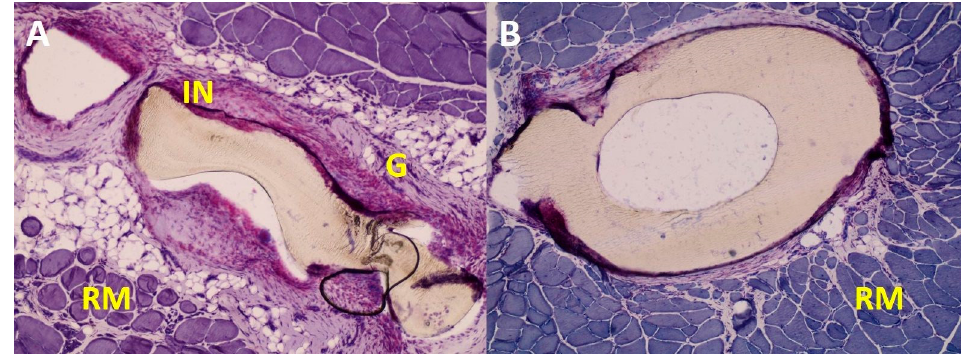
Figure 7. Exemplary images of the tissue around otoimplant after 360 days after the implantation. AP staining, magnification 10×. The images show the differences in the reconstruction of tissues around the implant parts: the antenna ( A ) and the cup ( B ).